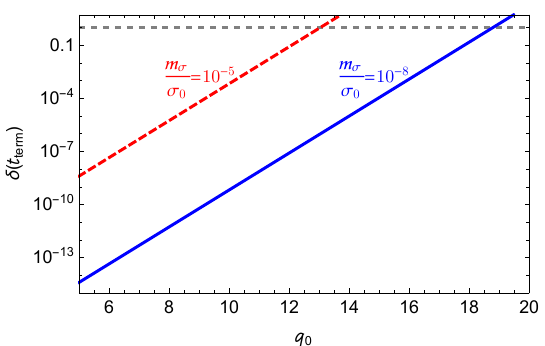
Figure 11 . ρ ψ /ρ σ + ψ as a function of q 0 for three different values of m σ /σ 0 based on the estimate in eq. (3.13). The grey dashed horizontal line indicates 1. When ρ ψ /ρ σ + ψ gets close to the line, feedback from ψ to σ is